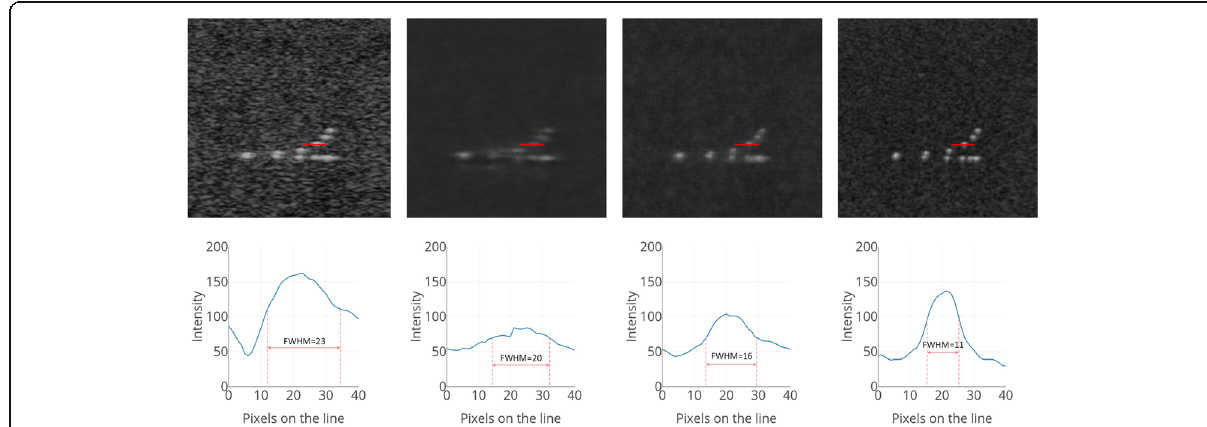
Fig. 10 The left column from top to bottom are a low-quality image, an image generated without differential loss, an image generated with differential loss, and a high-quality image. The right column shows the intensity on the red line of the corresponding image. Intensity values range from 0 to